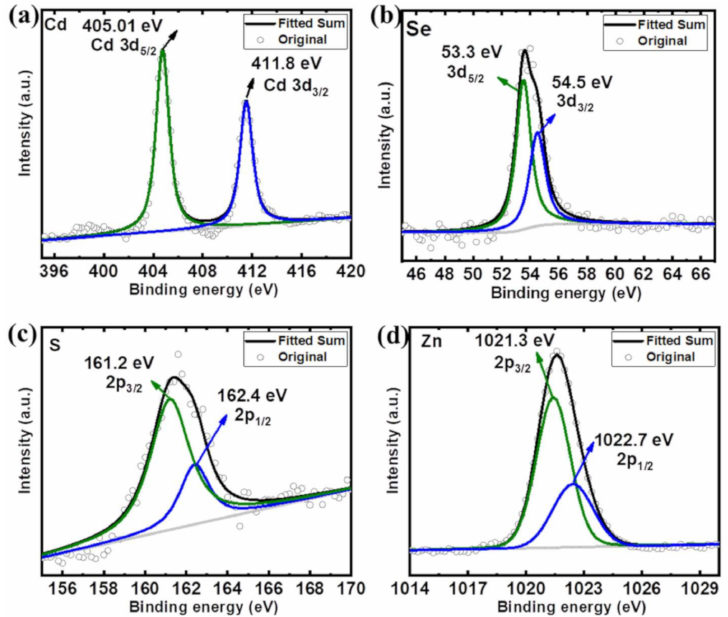
Figure 6. The XPS spectra of ( a ) Cd 3d, ( b ) Se 3d, ( c ) S 2p, and ( d ) Zn 2p in the QDs-OLA